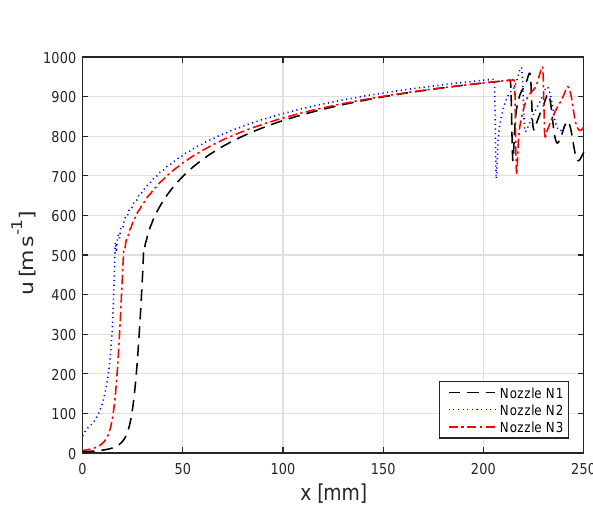
Figure 4. Geometry of computational domain and boundaries.